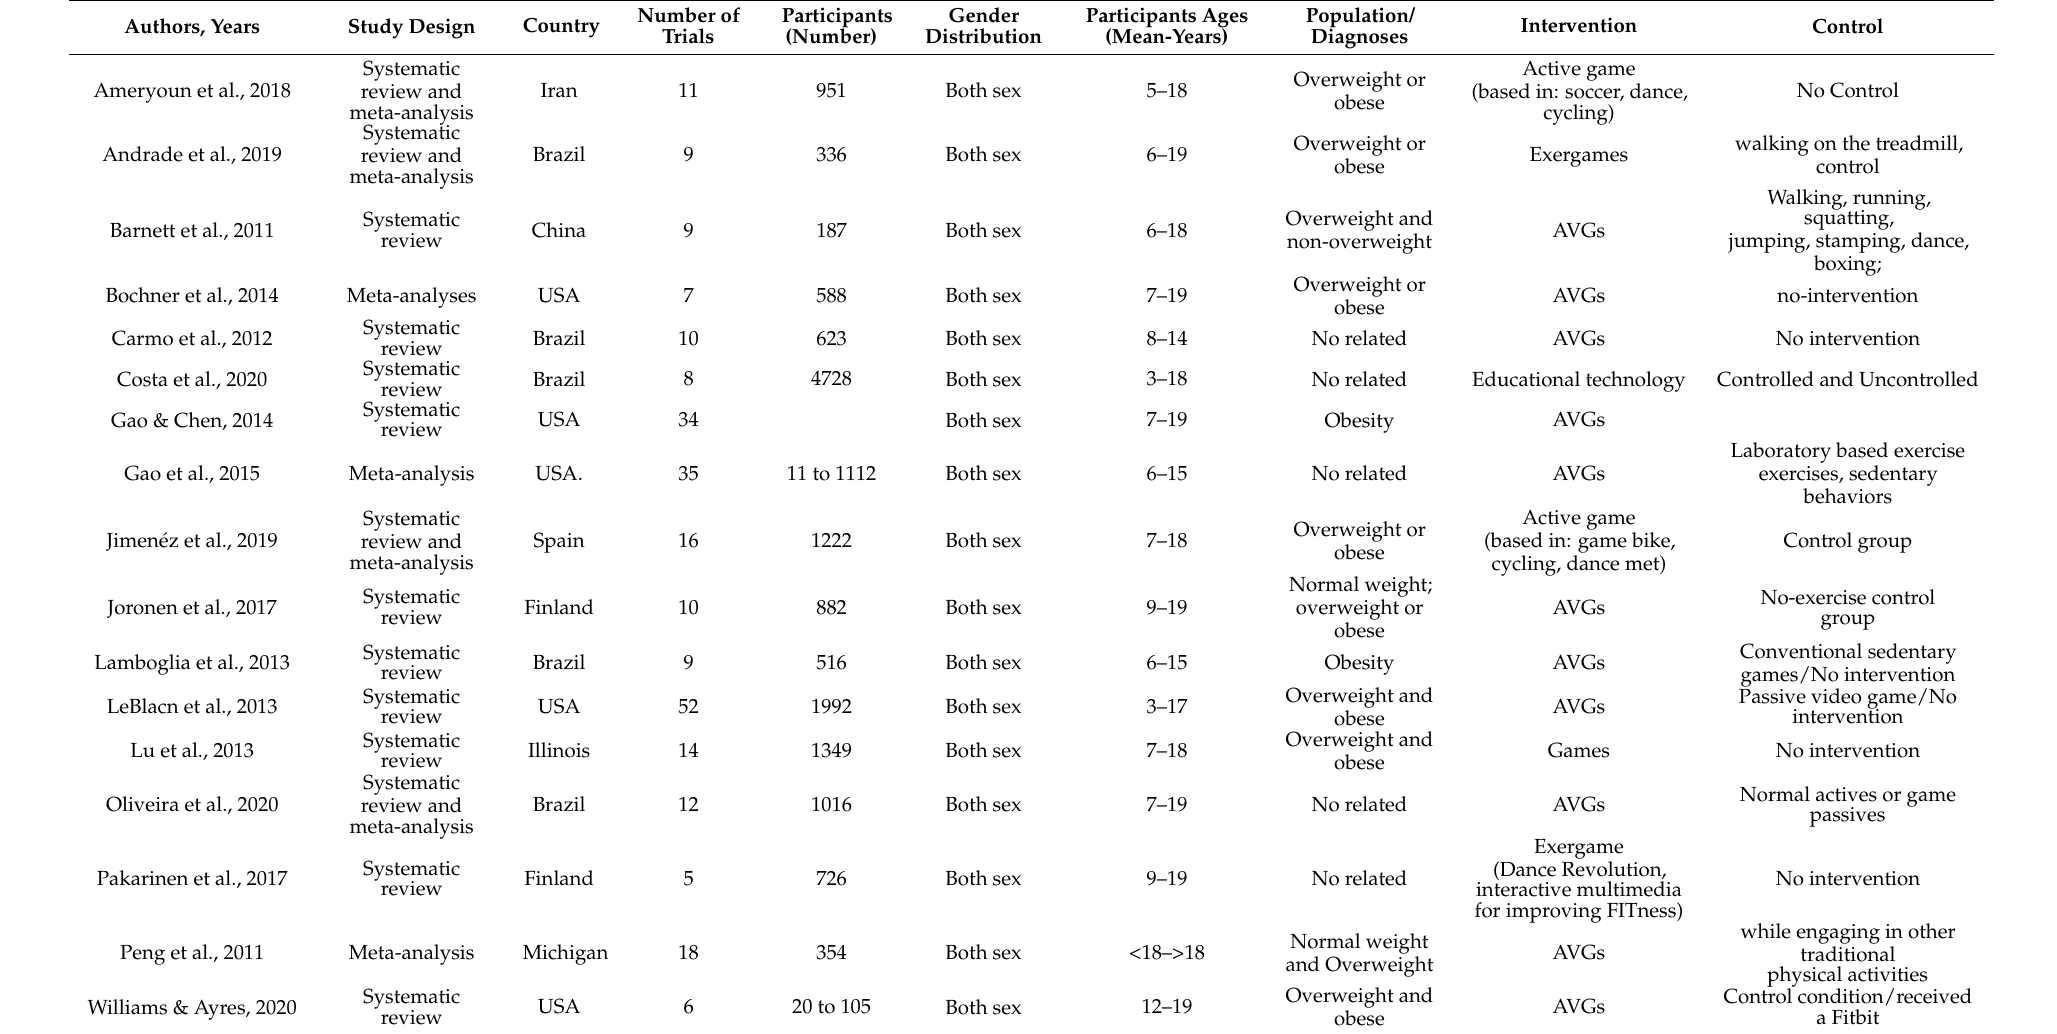
Table 1. Characteristics of systematic reviews or